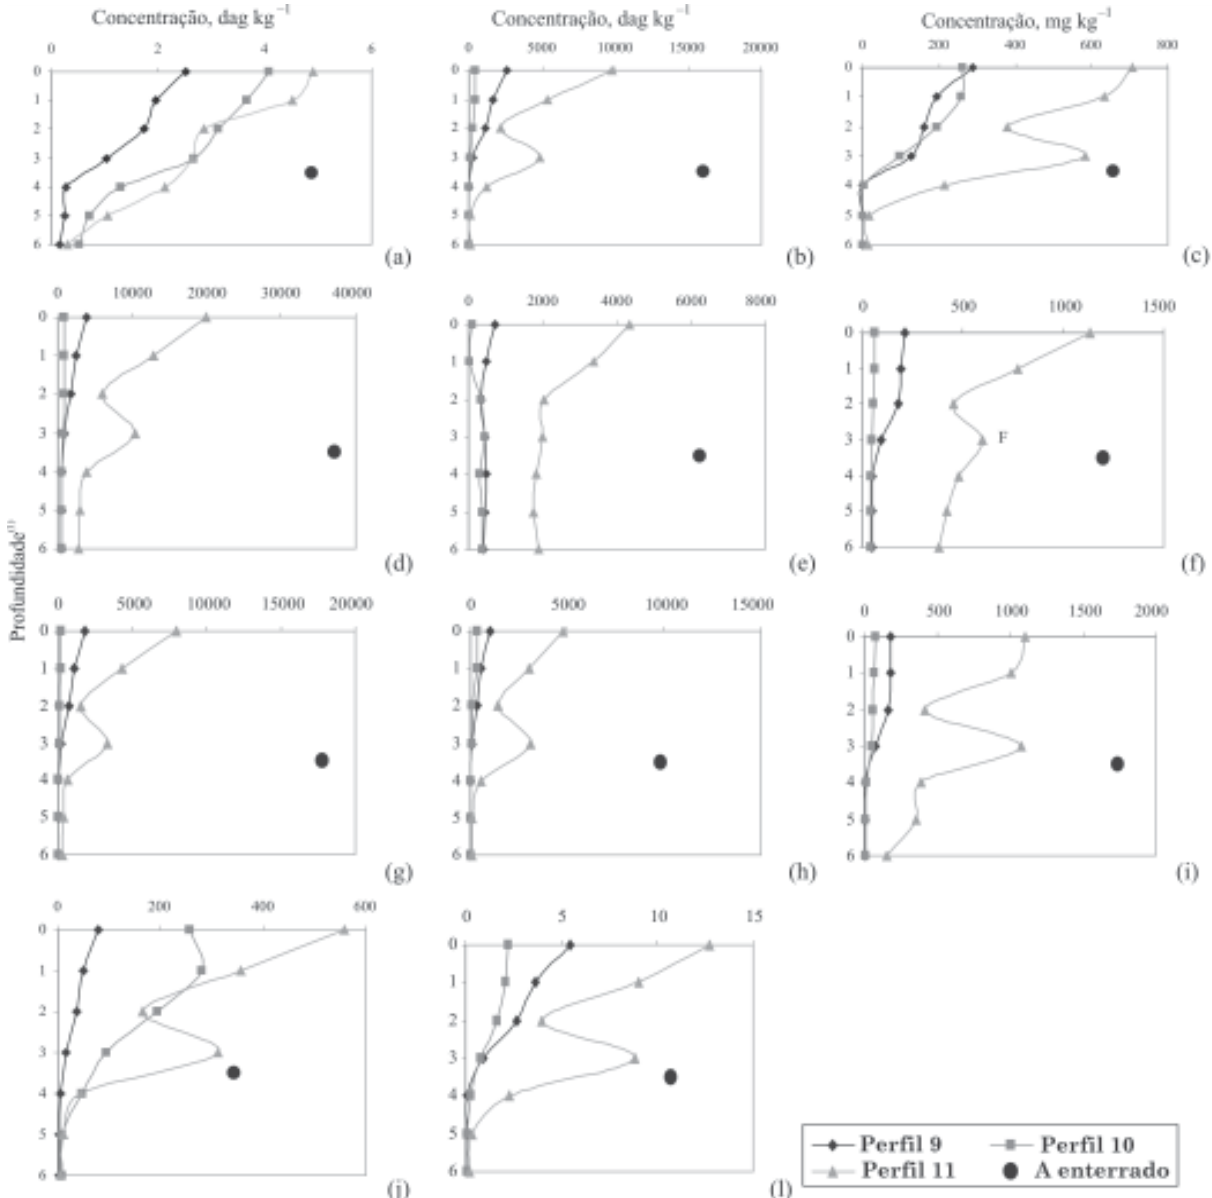
Figura 2. Teores de carbono orgânico e de Zn de acordo com a profundidade, nos perfis de solos da área em estudo. (a) – C orgânico; (b) – Zn extraído por Mehlich; (c) – Zn extraído por DTPA; (d) – Zn Total; (e) – Fração Residual de Zn; (f) – Zn associado aos óxidos cristalinos; (g) – Zn associado aos óxidos amorfos; (h) – Zn associado a carbonatos; (i) – Zn associado à matéria orgânica; (j) – Zn trocável e l – Zn solúvel. (1) As profundidades 0, 1, 2, 3, 4, 5 e 6 correspondem a 0 - 2, 2 - 5, 5 - 10, 10 - 20, 20 - 50, 50 - 100 e 100 - 150 cm,